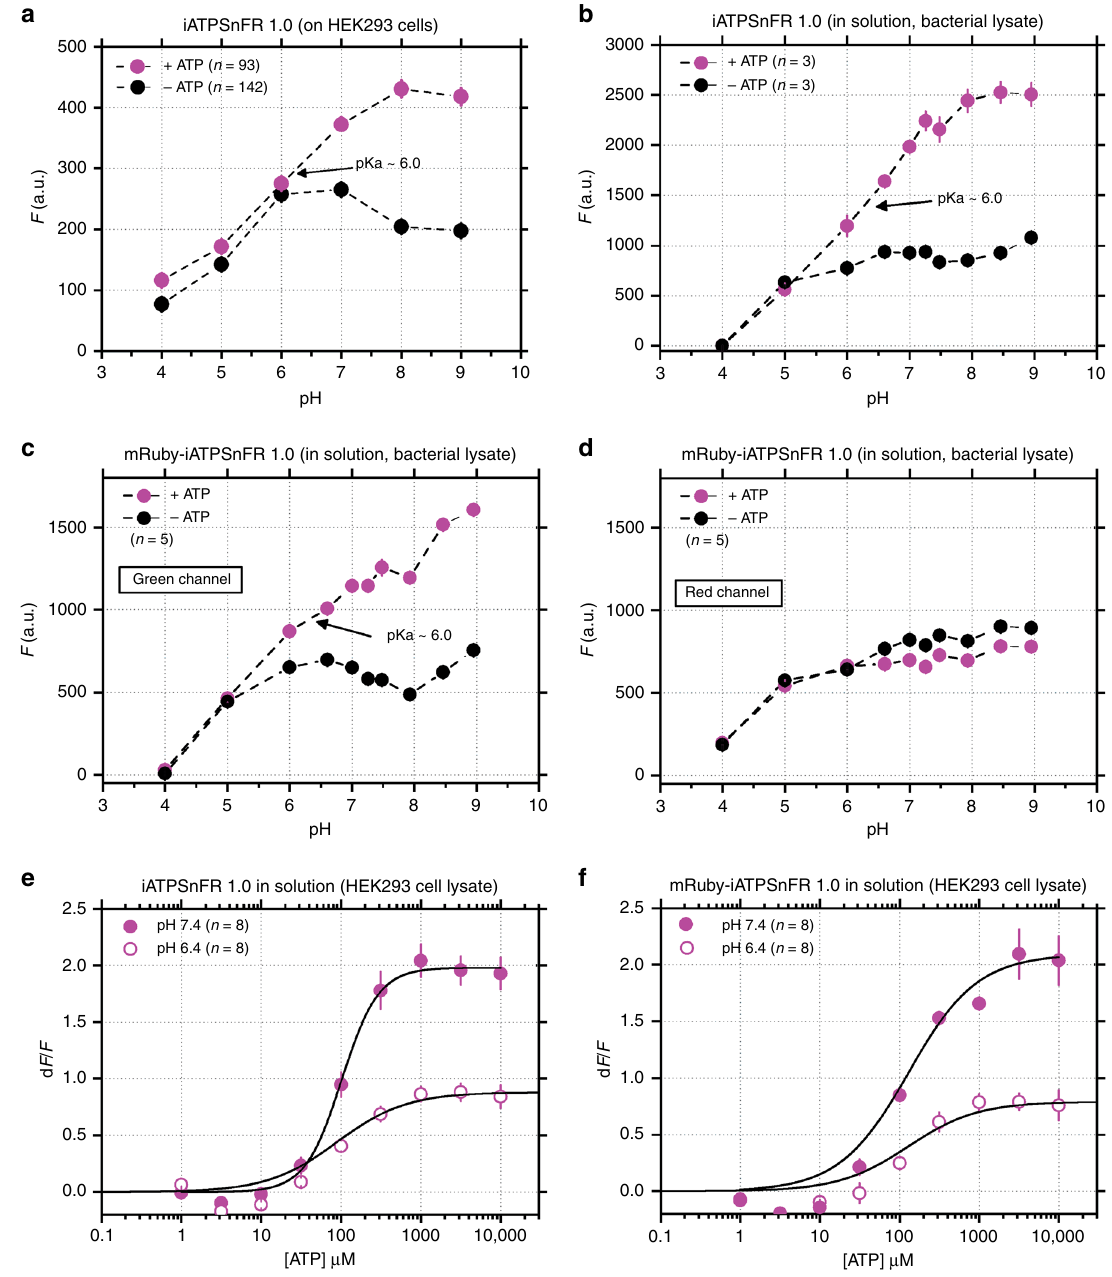
Fig. 7 Assessments of how iATPSnFR 1.0 was affected by pH. a – d Effect of pH on the unbound and ATP bound fl uorescence of the indicated constructs. e , f Comparison of the effect of ATP on the fl uorescence of the indicated constructs at pH 6.4 and 7.4. The error bars represent the s.e.m. and in some cases are smaller than the symbols used for the mean. n numbers are provided in the fi gure panels and refer to the number of cells in panel ( a ), and number of independent evaluations in ( b – f